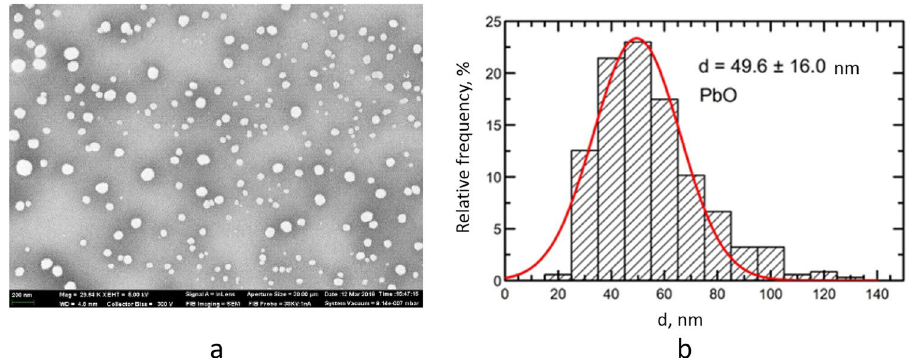
Figure 9. Description of PbO nanoparticles used in the experiment: ( a ) a scanning transmission electron microscopy image of PbO nanoparticles in the suspension at 29,640 × magnification, and ( b ) the function of PbO nanoparticle size